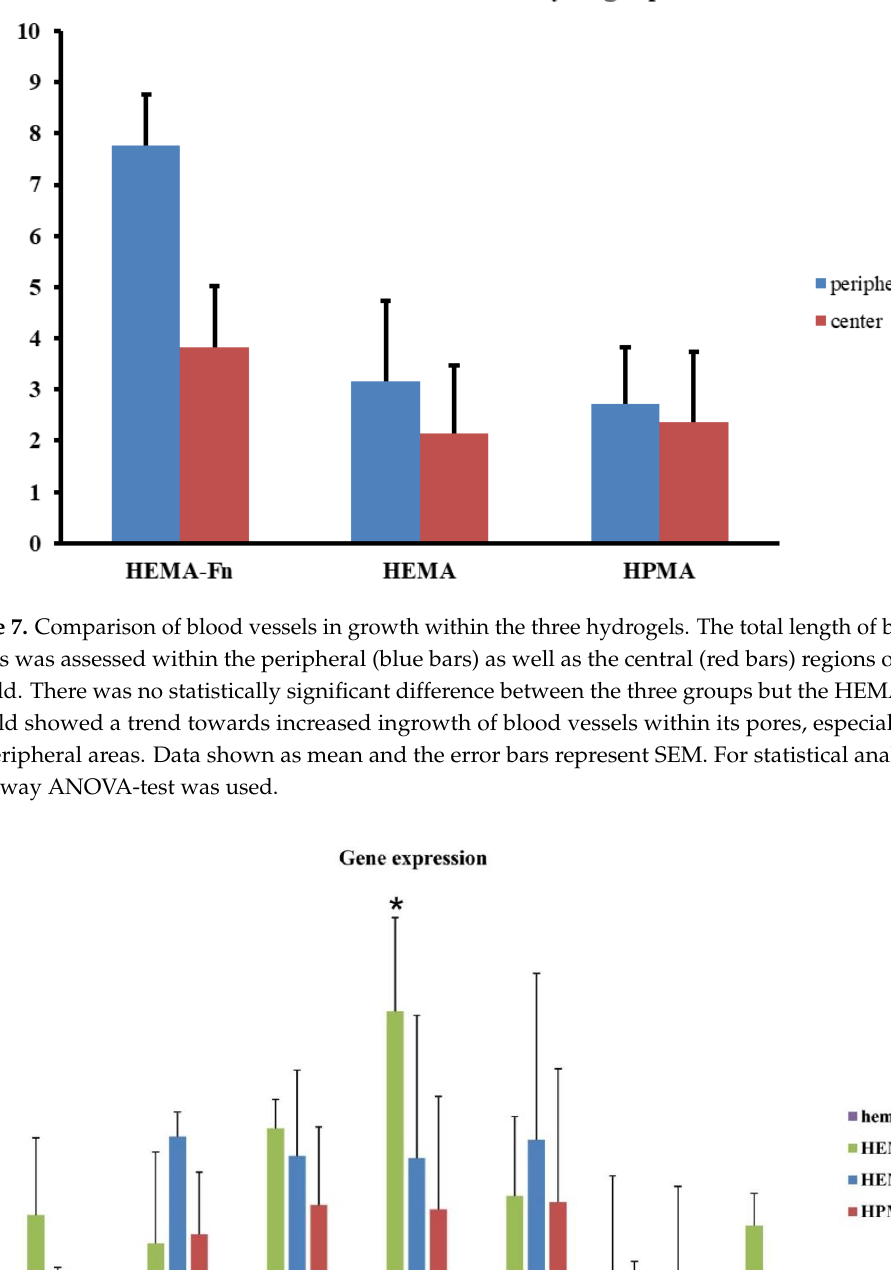
pores of the scaffold compared to both HEMA hydrogels (* p < 0.05, ▲ p < 0.05). The graph shows that there were no axons within the HEMA scaffold, while the modification of fibronectin (HEMA-Fn) showed at least some axonal infiltration with the periphery and some even grew as far as the central parts of the scaffold. Data shown as mean and the error bars represent SEM. For statistical analysis, a one-way ANOVA test was used.